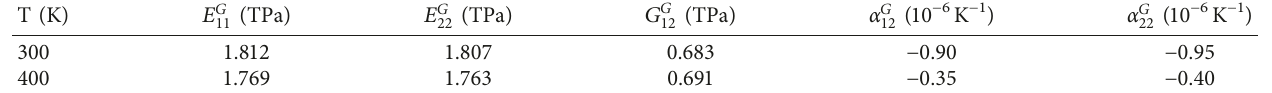
Table 1: Temperature-dependent material characteristics of monolayer graphene.